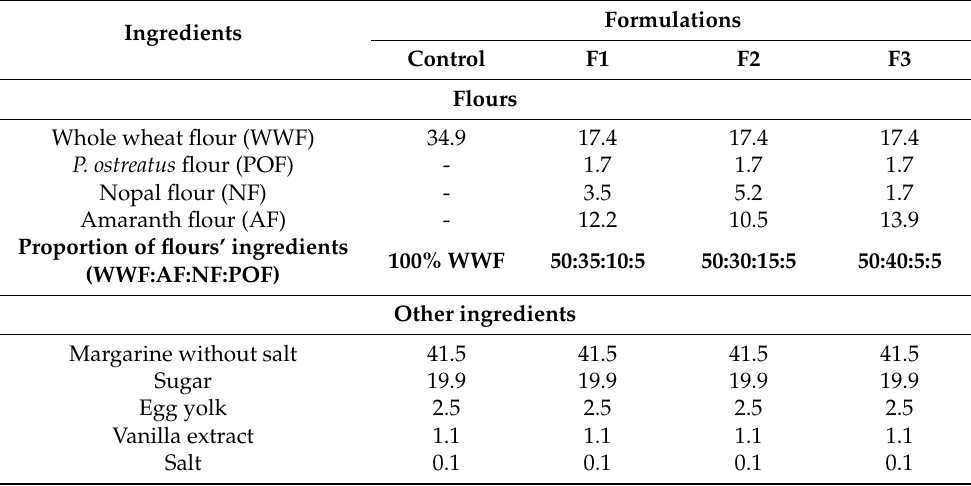
Table 1. Composition of control (whole wheat flour-based formulation) and those fortified with the functional flours used in cookies’ preparation (g/100 g of formulation).